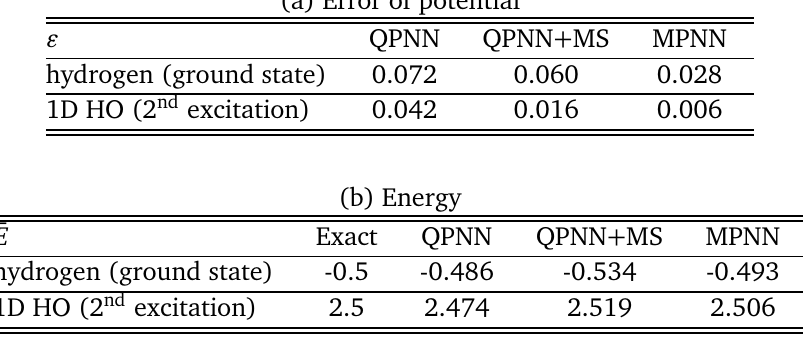
Table 1: (a) The error of potential (cid:34) in Eq. (10) and (b) the energy ¯ E obtained by QPNN, QPNN with Metropolis sampling (MS) as another baseline for comparison, and MPNN. We take the ground state of the hydrogen atom and the second excited state of 1D harmonic oscillator (HO) as examples. The numbers of hidden variables in the three layers of the NN are taken as 32, 128, and 128, respectively, same as those in Ref. [ 31 ] . See more details about the evaluations of the error and energy for these three methods in the main